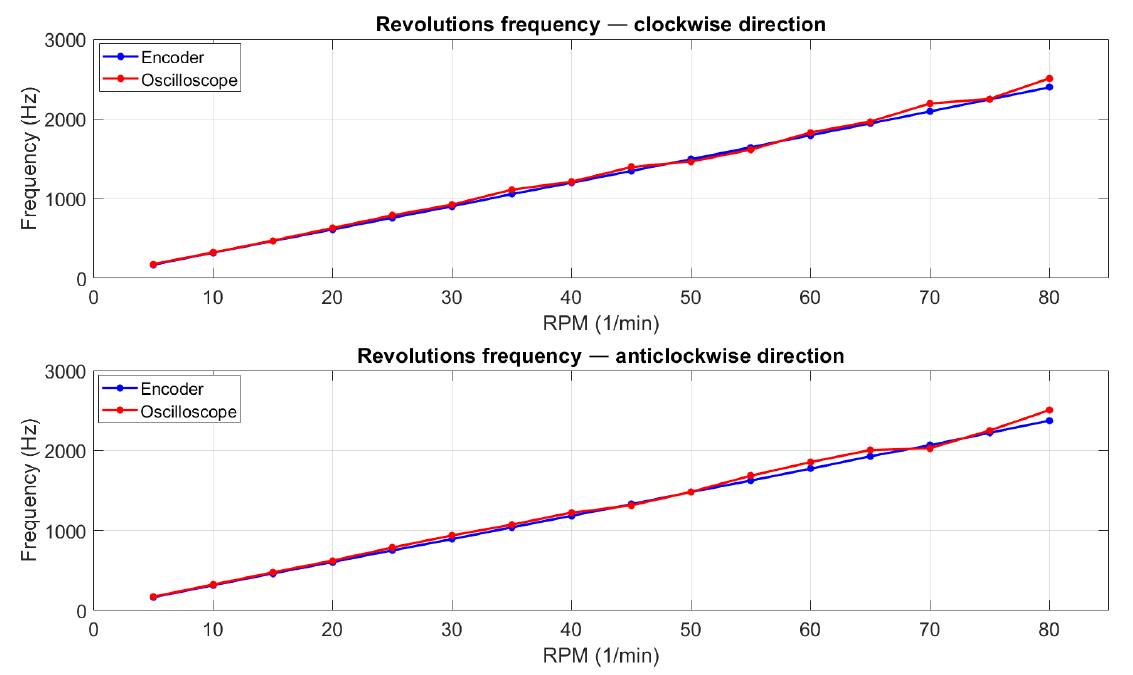
Figure 13. Plots with curves representing encoder and oscilloscope measurement values of rotation frequency.